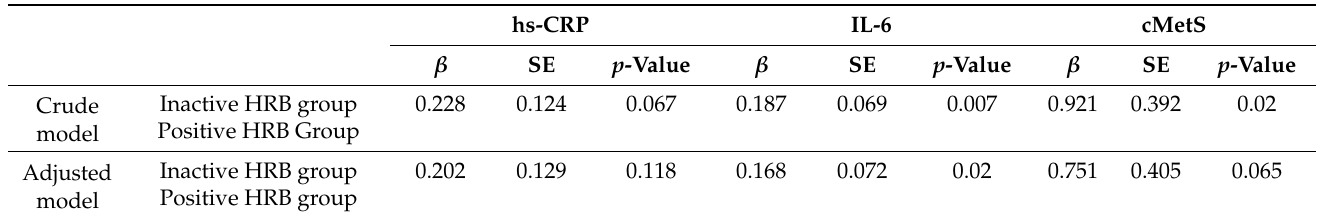
Table 2. Multiple linear regression analysis for the association between latent group for health-related behaviors and metabolic risk factors. hs-CRP IL-6